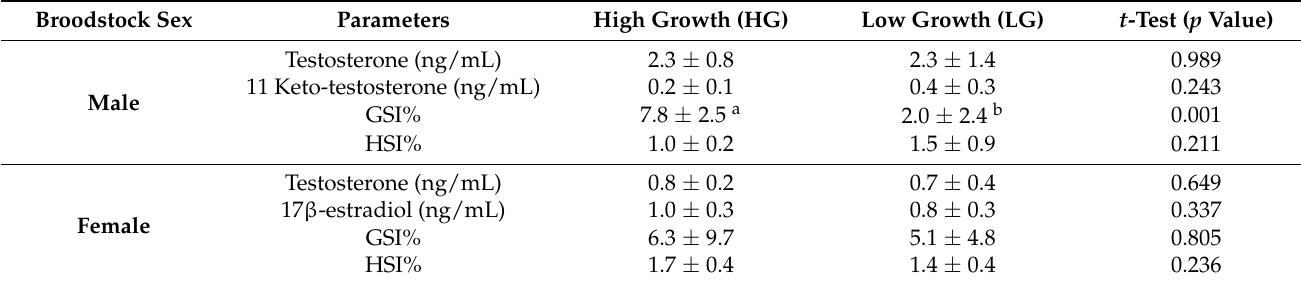
Different superscripts in each row indicate significant differences among HG or LG broodfish groups ( p < 0.05, independent sample t -test). GSI (%) (gonadosomatic index) = (Gonad weight, g/weight of fish, g) × 100; HSI (%) (hepatosomatic index) = (Liver weight, g/weight of fish, g) × 100.